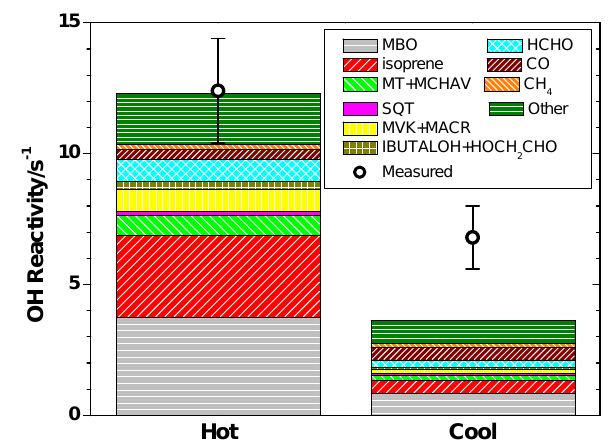
Fig. 3. Modeled OH reactivity for the hot (left) and cool (right) peri- ods at z/h = 1 (10m). The “other” category contains contributions from ∼ 300 reactions. Open circles and error bars denote measured bulk OH reactivity (mean ± 1 σ